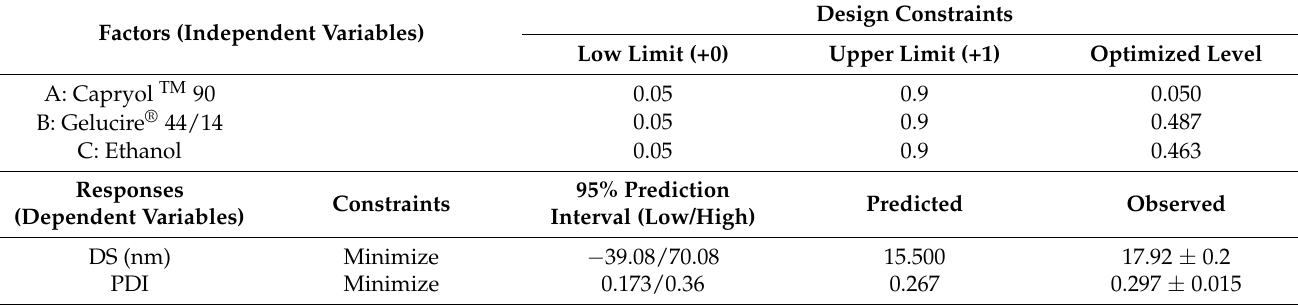
Table 5. Independent variables and respective limits for Fr-SNEDS formulations, model summary statistics of a quadratic model, constraints for optimization, factors levels for optimized Fr-SNEDS formulation, and their predicted and ob- served values.